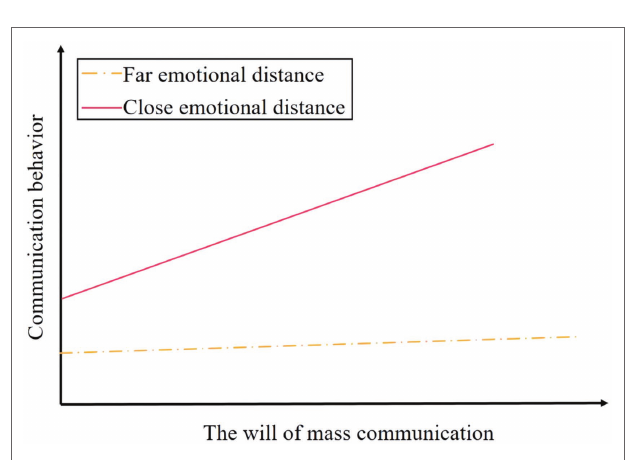
FIGURE 6 | Negative adjustment effect of sensory